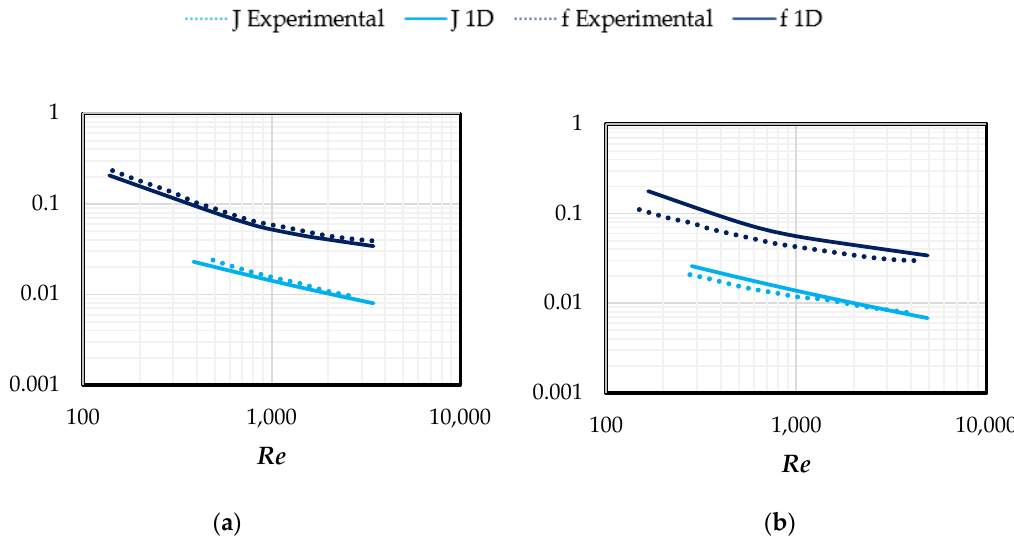
Figure 9. Comparison between experimental and analytical data. Colburn factor (cyan) and friction factor (blue). ( a ) Fin geometry 1/10-27.03. ( b ) Fin geometry 1/8-16.00(D).